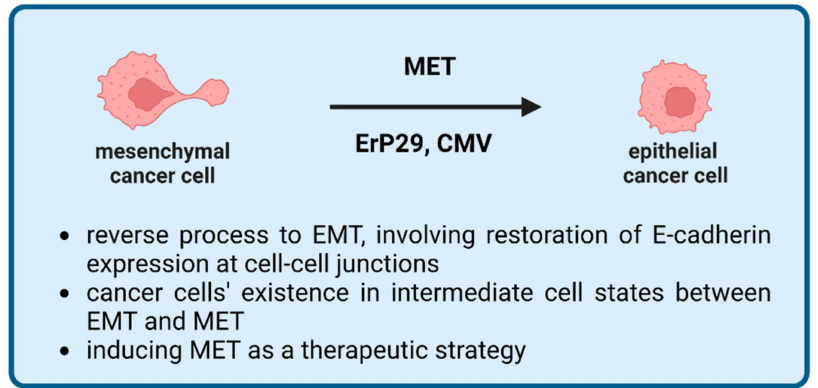
Figure 4. Mesenchymal-to-epithelial transition (MET) is the reverse process to EMT. In MET, mes- enchymal cells gain epithelial traits. MET can be considered as an early stage of adaptation for CTCs to a new environment, and its induction has been discussed as a potential therapeutic strategy. MET involves numerous genes/proteins and other external factors including, but not limited to, ErP29 or CMV. Created with